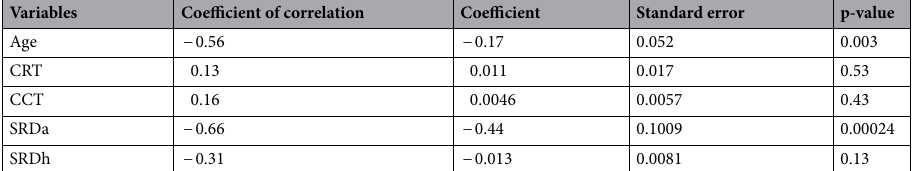
Table 4. Result of univariate analysis between the mean overall retinal sensitivity of short wavelength automated perimetry (S-RS) and OCT parameters. CRT central retinal thickness, CCT central choroidal thickness, SRDa area sum of all observed SRD regions (foveal and extra-foveal), SRDh SRD height at the fovea.